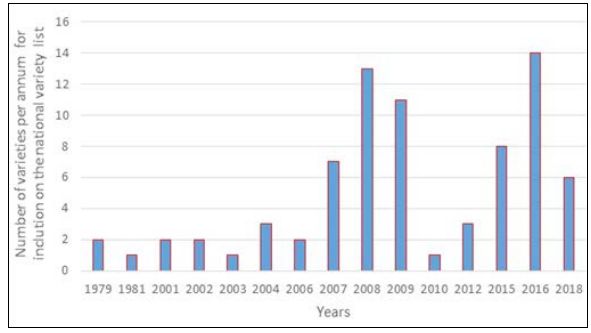
Annual applications for the inclusion of sunflower varieties on the national variety list,